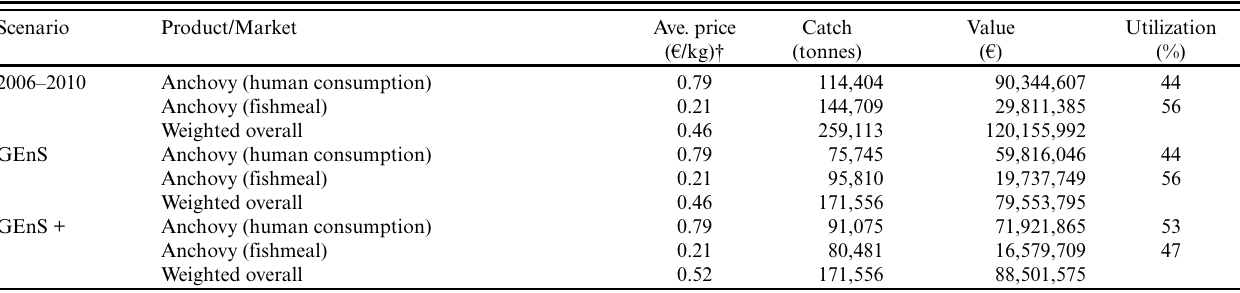
Table 6 . Estimated annual average economic yields derived from anchovy catches by Turkish fishers under historic and Good Environmental Status (GEnS) and GEnS plus reduced fishmeal